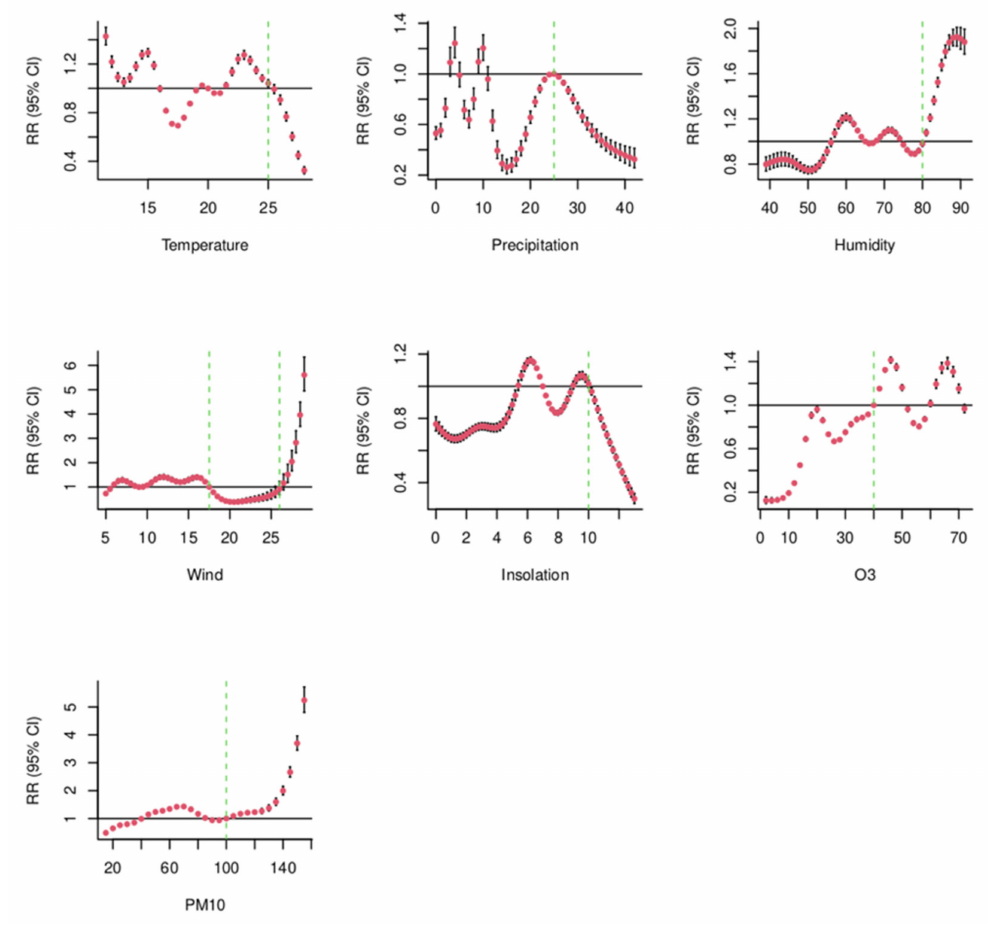
Figure 5. Risk Ratios with 95% confidence intervals increase of daily confirmed COVID-19 associated to change in temperature, humidity, precipitation, wind, insolation, O 3, and